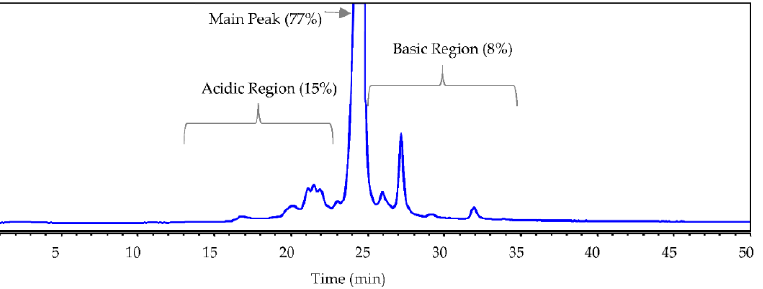
Figure 1. The mAb1 IEC profile by cation exchange chromatography at pH 7 with a salt gradient.